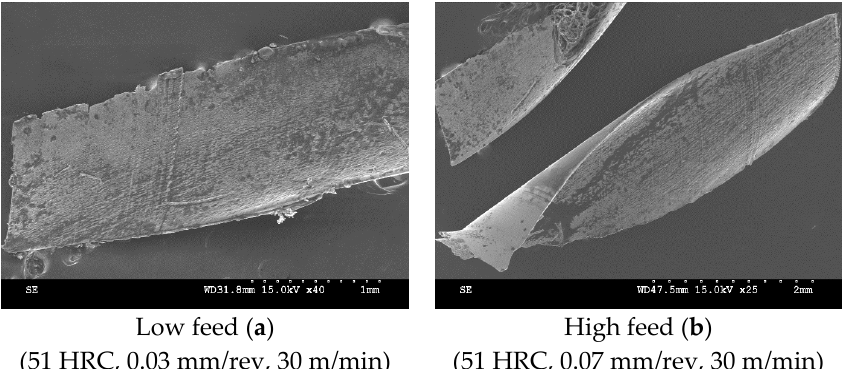
Figure 20. Cutting tool chips of 51 HRC Rene 65 samples at: ( a ) low feed, ( b ) high feed.